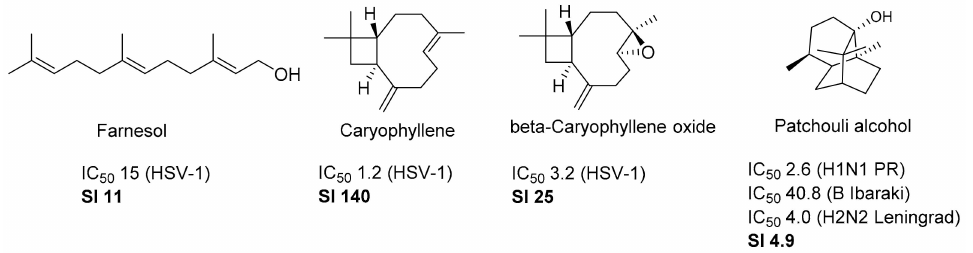
Figure 1. Structures of sesquiterpenoids with antiviral